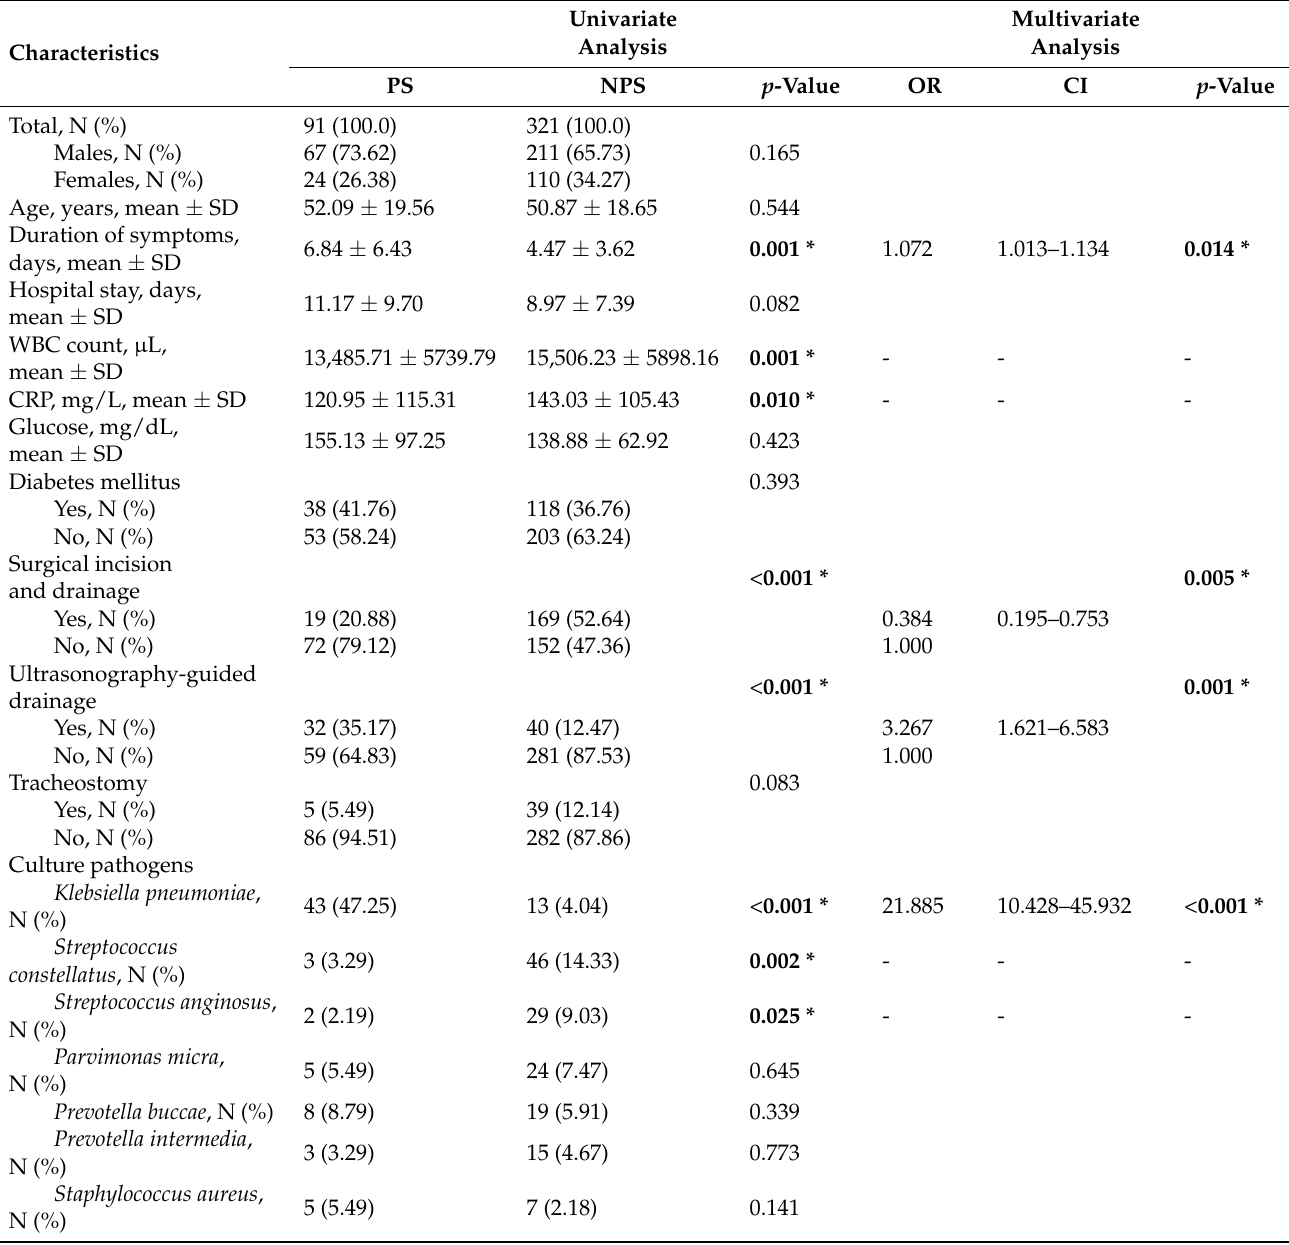
Table 2. Clinical data from the PS and NPS deep neck infection subgroups.